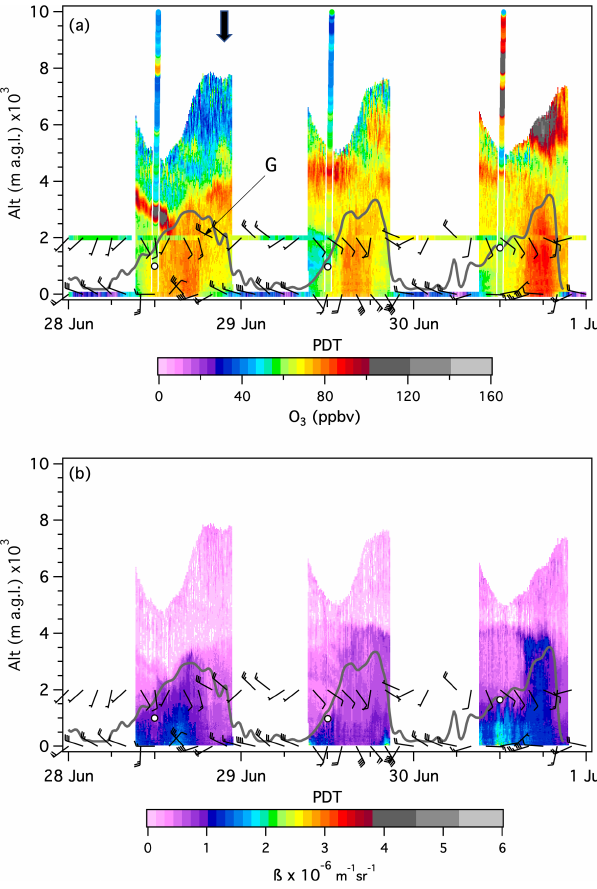
Figure 13. Same as Fig. 11, but for IOP3. The heavy black arrow corresponds to the 12:00UT 12 June 300hPa plot in Fig. 3d.